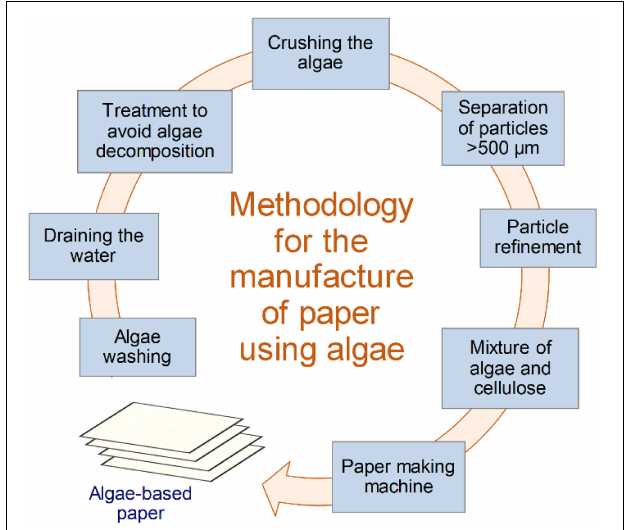
FIGURE 8 | Manufacturing process of paper made from algae.